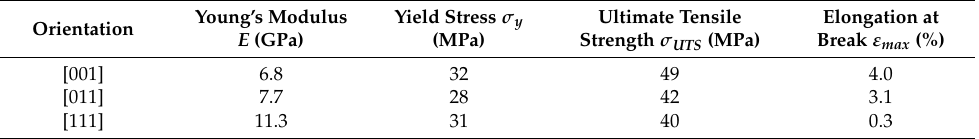
Table 3. Mechanical properties of lattice specimens evaluated from tensile